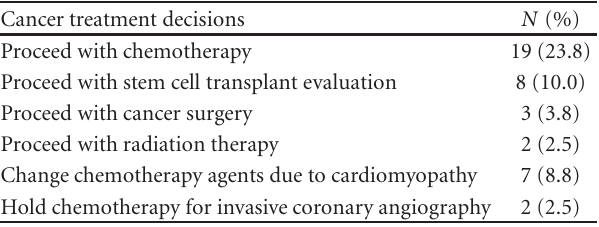
Table 6: Impact of cardiac computed tomographic angiography on cancer-related treatment